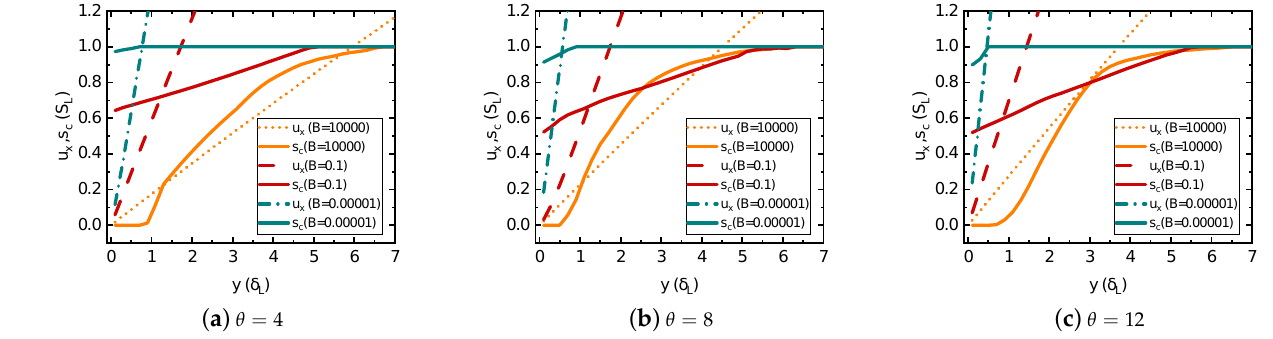
Figure 15. Comparison of the consumption speed s c ( y ) and the incoming flow velocity u x ( y ) for heat transfer coefficients B = 10 4 ,0.1,10 − 5 and thermal gas expansion coefficients θ = 4,8,12 at the critical condition ( R = 60 δ L